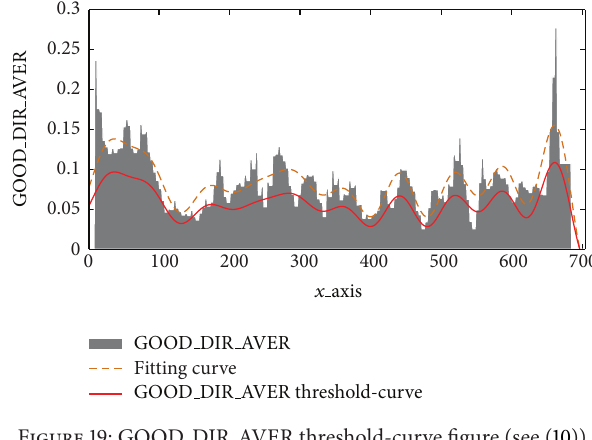
Figure 19: GOOD DIR AVER threshold-curve figure (see (10)).